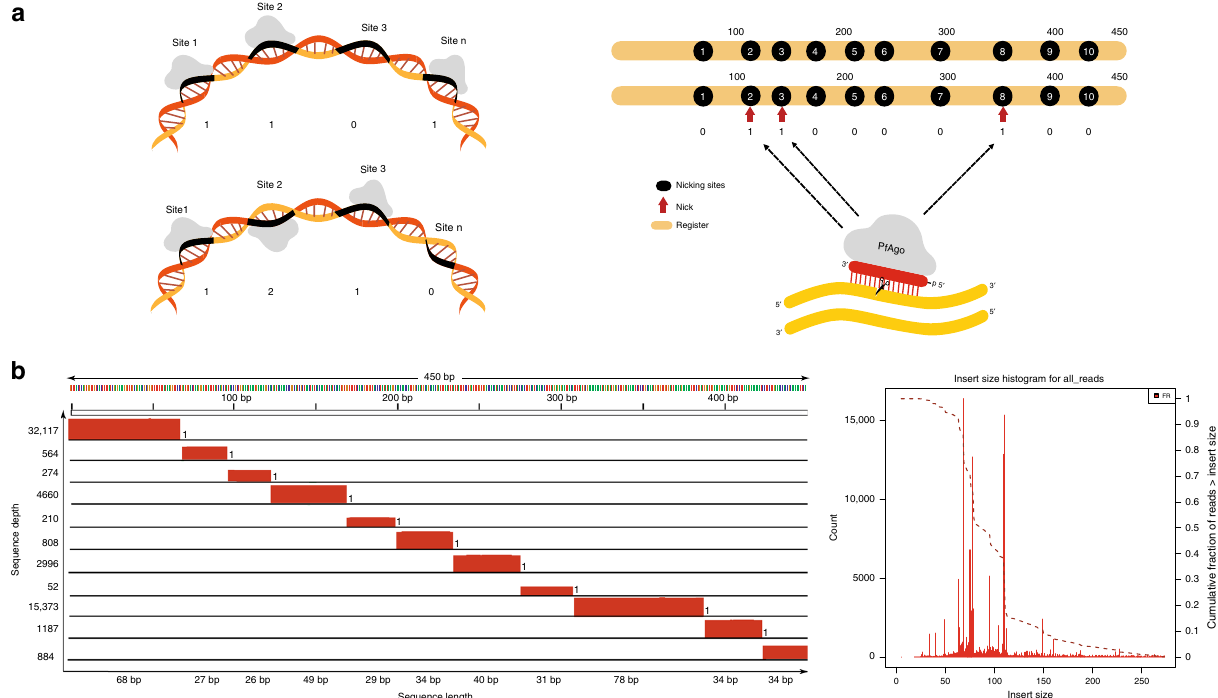
Fig. 2 Writing and reading the encoded data. a Pf Ago can nick several pre-designated locations on only one strand (left, top) or both strands (left, bottom), simultaneously. In the fi rst register, the stored content is 110 … 1, while in the second register, the content is 121 … 0. The chosen register is a PCR product of a 450 bp E. coli genomic DNA fragment with 10 pre-designated non-uniformly spaced nicking positions. The positional code 238 corresponds to the binary vector 0110000100 (right). b The MiSeq sequencing reads were aligned to the reference register to determine the positions of the nicks. The size distribution histogram (right) and coverage plots (left) are then generated based on the frequency and coverage depth of the reads. Coverage plots allow for straightforward detection of nicked and unnicked sites. In the example shown, all the ten positions were nicked, resulting in eleven aligned fragments. Source data are available in the Source Data fi